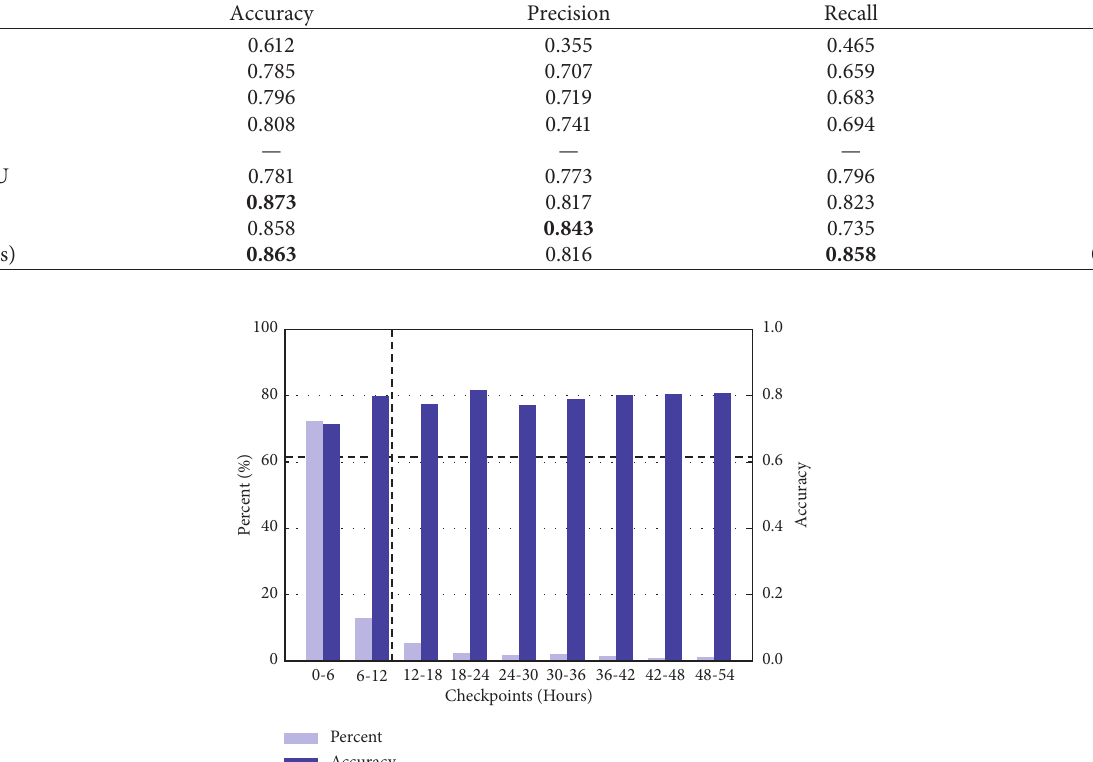
Table 3: Detection accuracy on Twitter.